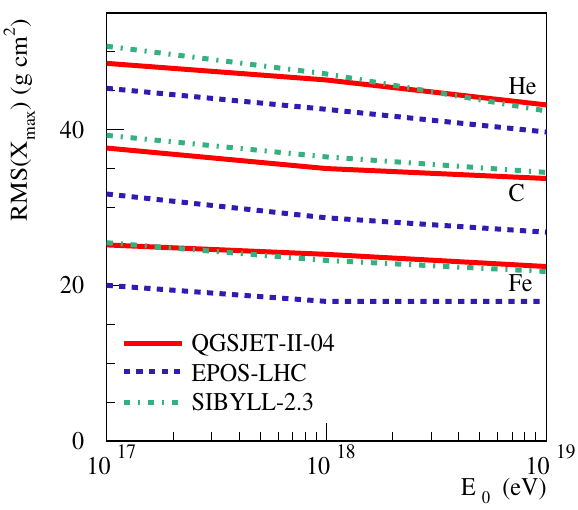
Figure 8. Primary energy dependence of RMS( X max ) for (from top to bottom) He-, C-, and Fe-induced vertical EAS, as cal- culated using the QGSJET-II-04, EPOS-LHC, and SIBYLL-2.3 models (solid, dashed, and dashed-dotted lines respectively).